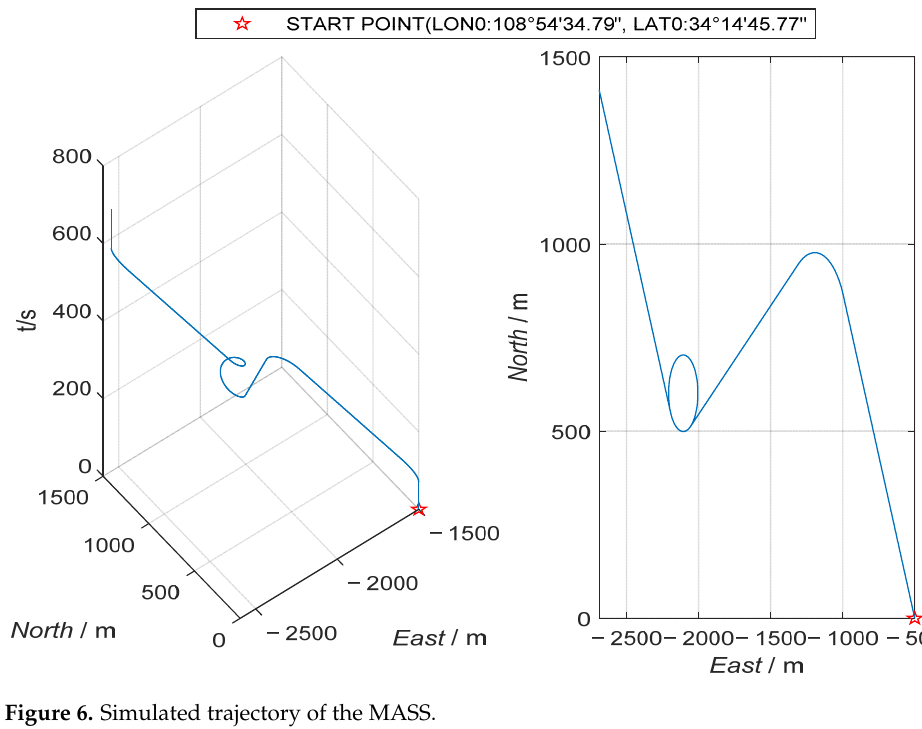
Figure 6. Simulated trajectory of the MASS.